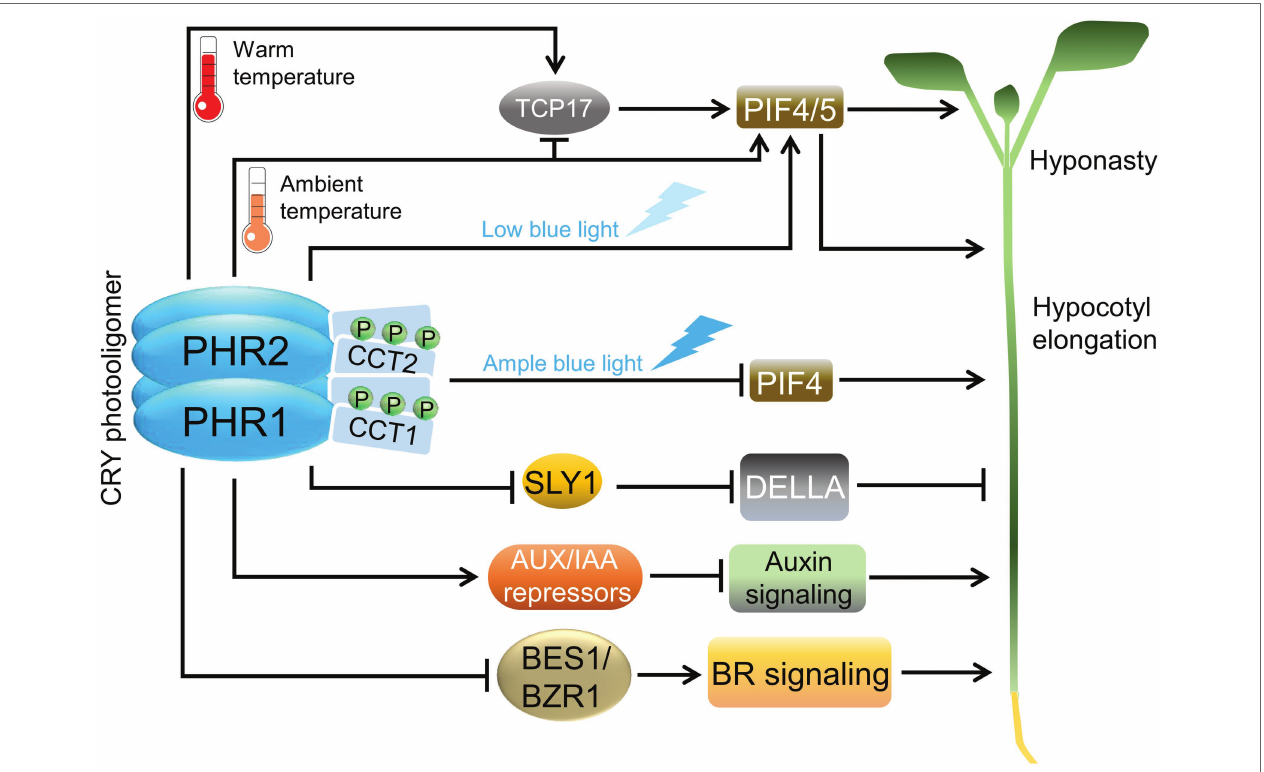
FIGURE 3 | Cryptochromes in warm temperature and hormone signaling. Abbreviations: PHR, photolyase homology region; CCT, CRY carboxy terminus; TCP17, TCP DOMAIN PROTEIN 17; SLY1, SLEEPY1; AUX/IAA, AUXIN/INDOLE-3-ACETIC ACID; BES1, BRI1-EMS-SUPPRESSOR 1; BZR1, BRASSINAZOLE-RESISTANT 1; PIF, PHYTOCHROME-INTERACTING FACTOR; DELLA, DELLA domain-containing protein; BR,